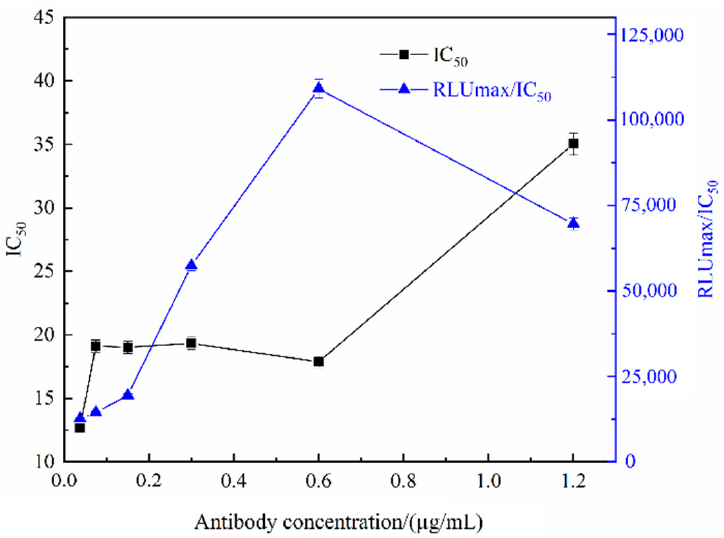
Figure 2. The IC 50 and RLUmax/IC 50 of ic-CLIEA with different antibody concentrations for ACE detection.